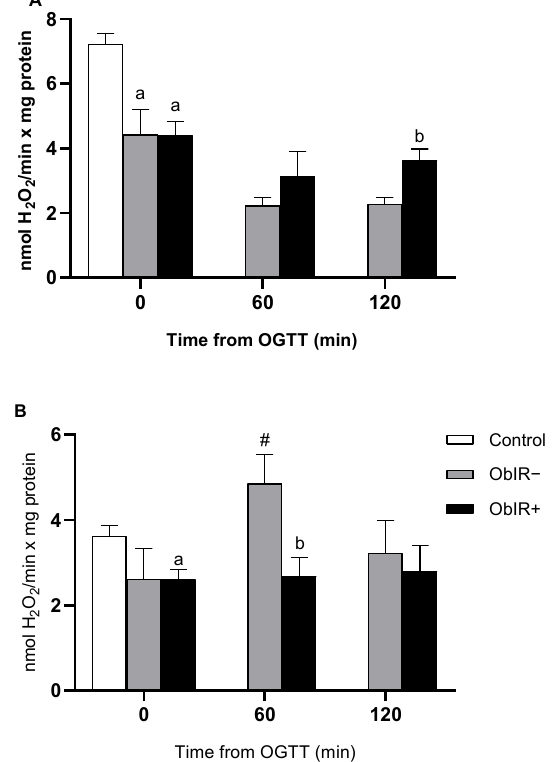
Figure 6. H 2 O 2 removing enzymes. Glutathione peroxidase ( A ) and catalase ( B ) were measured in RBCs of healthy and obese children at baseline and along OGTT. White bars represent the control group, grey bars represent ObIR − group, and black bars represent ObIR+ group. Values are means ± SEM. p < 0.05 was considered for statistical significance. (a) shows significant differences relative to control at baseline, (b) shows significant differences relative to ObIR − , and ( # ) shows intragroup